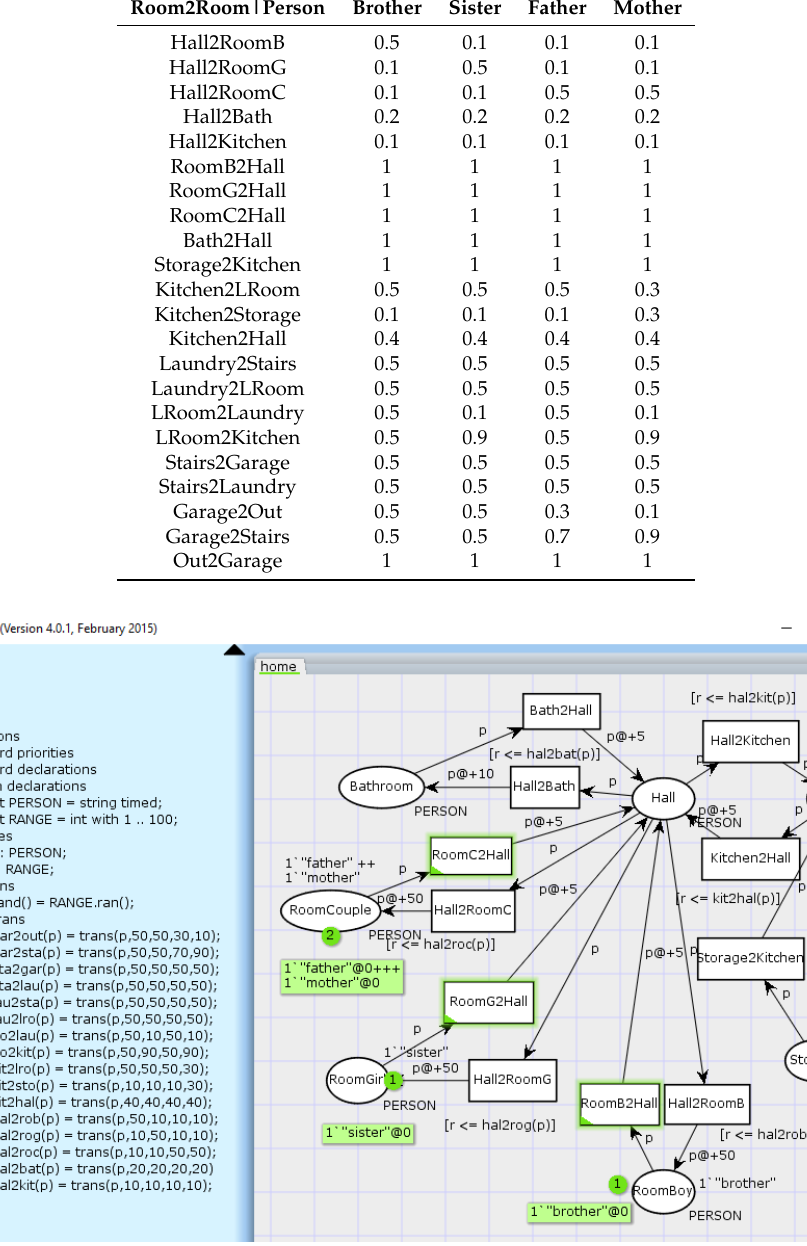
Figure 3. Coloured Petri Nets (CPN) ML declarations in CPN Tools for multi-user smart home data